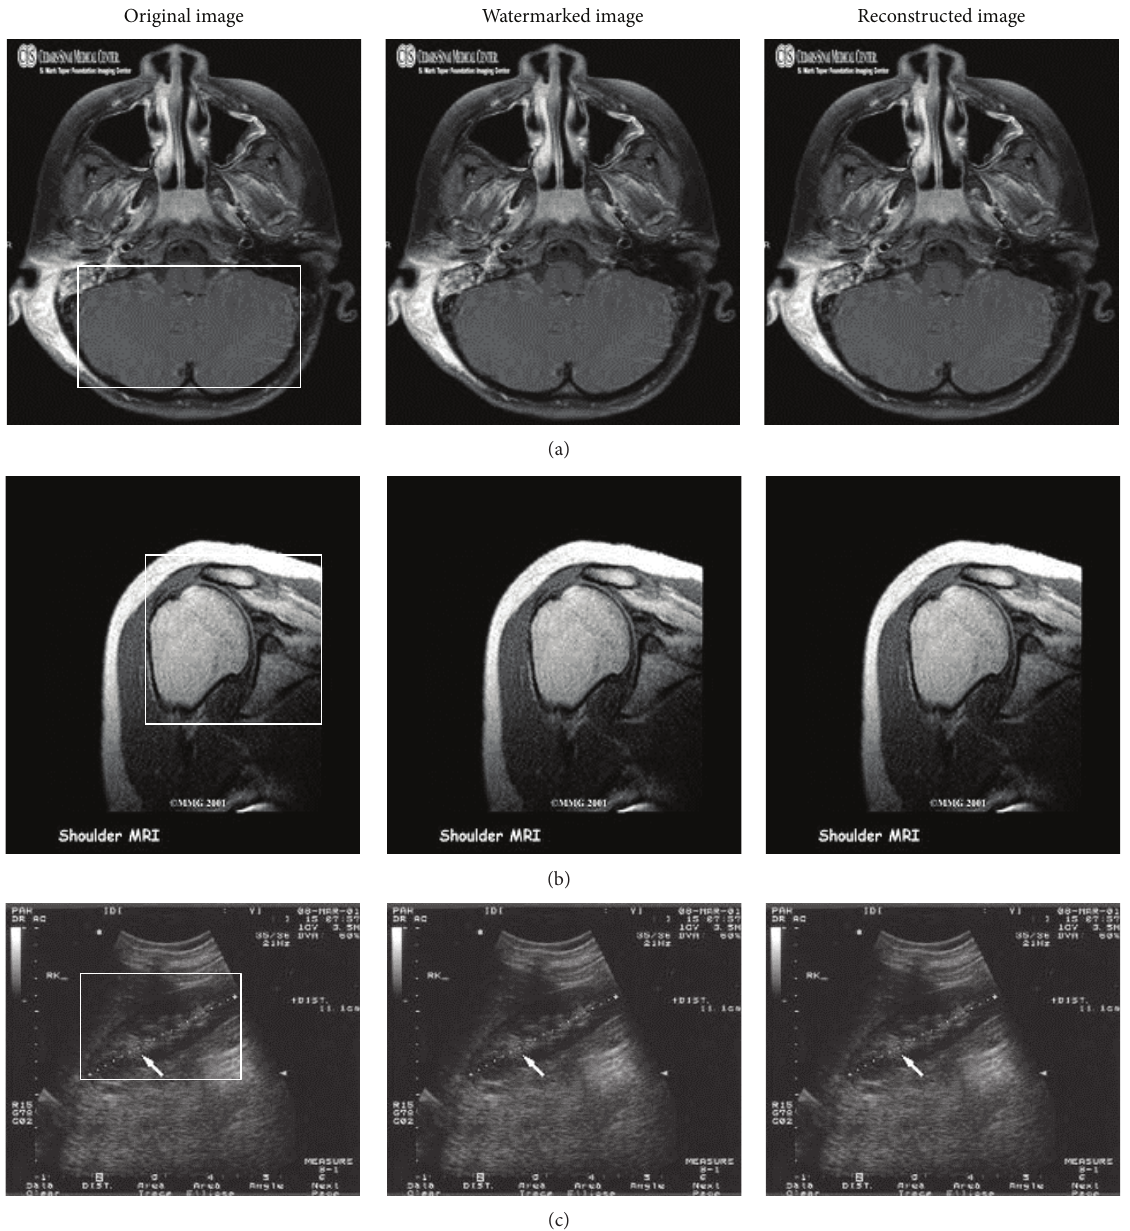
Figure 3: Original, watermarked, and reconstructed medical images. From top to bottom: CT scan, MRI scan, and ultrasound images.